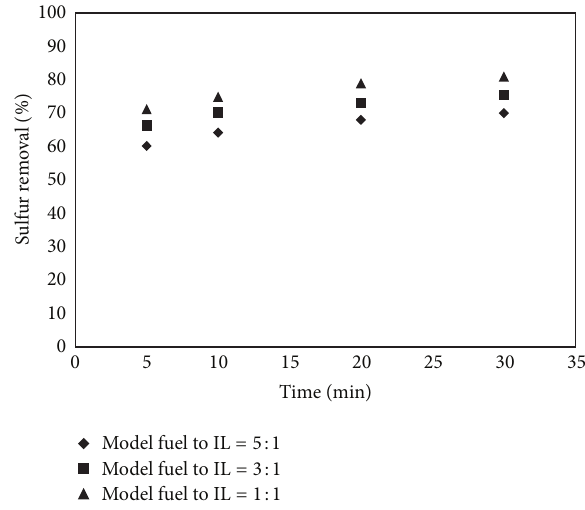
Figure 8: Removal of sulfur from model fuel (DBT in octane) using [BMIM]Cl at different extraction times (temperature = 30 ∘ C, extraction time = 5–30 min, initial Sulfur Concentration = 500 ppmw).